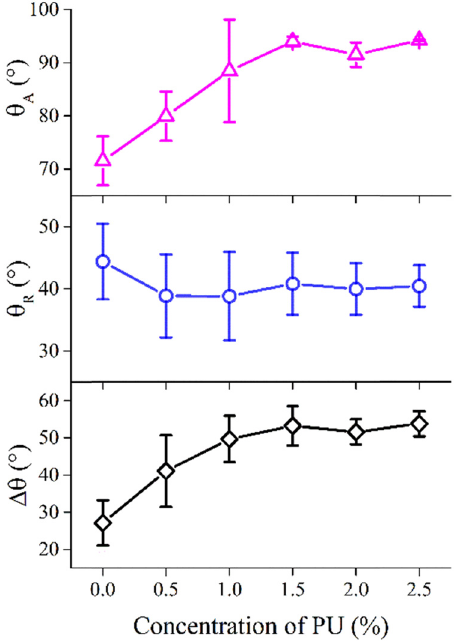
Figure 6: Advancing angle ( θ A ) , receding angle ( θ R ) , and contact angle hysteresis ( Δ θ ) of harness cord before and after PU